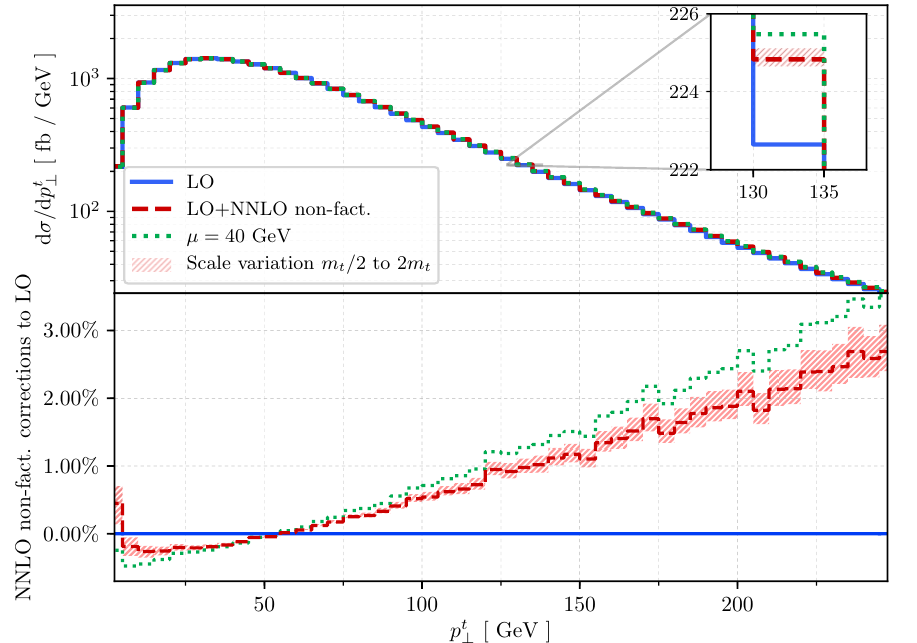
Figure 3. Distribution of the top-quark transverse momentum. The LO distribution is marked with a blue, solid line, while the red, dashed line corresponds to our predictions for the LO+NNLO distribution at µ = m t . The scale is variated between µ = m t / 2 and µ = 2 m t . The green, dotted line corresponds to the scale µ = 40 GeV. The lower pane shows the ratio of non-factorisable corrections to the LO distribution. See text for further details.